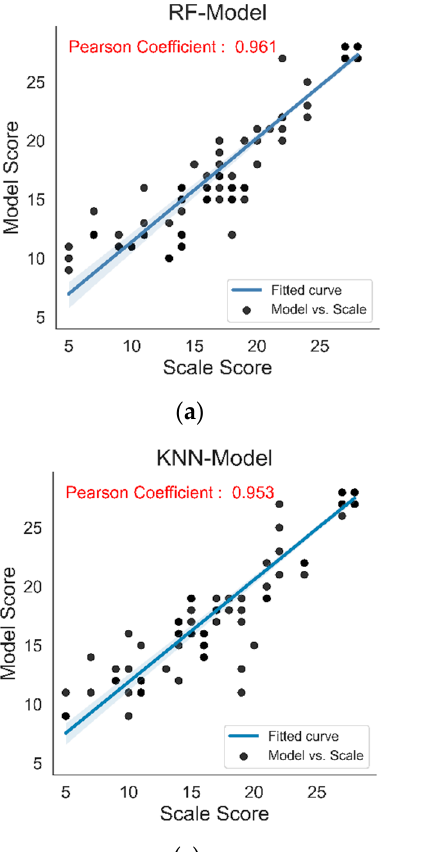
Table 4. Correlation analysis between the model’s prediction score and the doctor’s scale score.